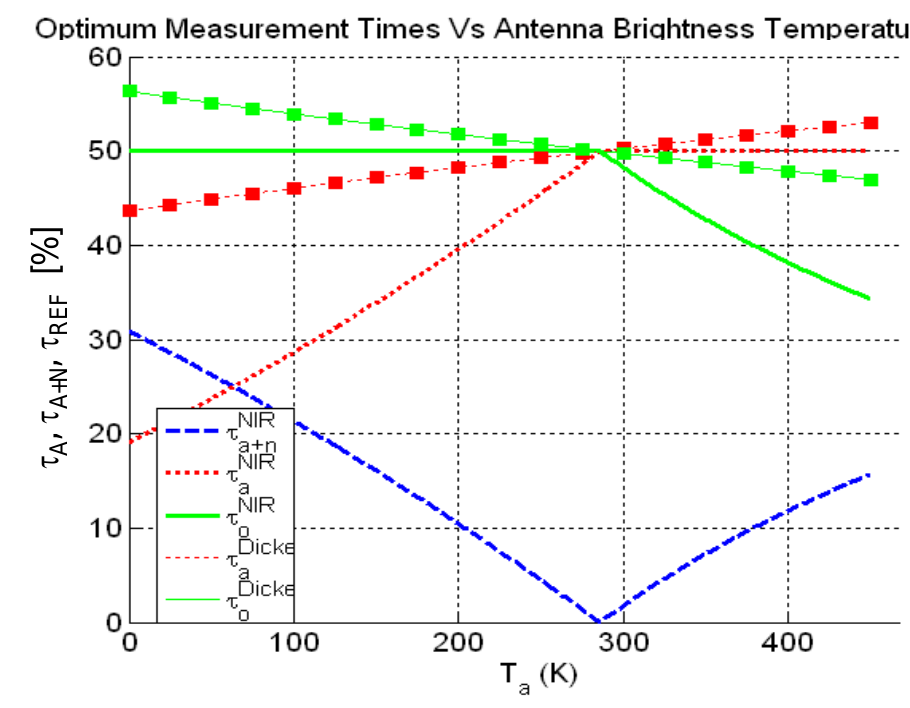
Figure 8. Optimum measurement times (τ time, for the NIR and the Dicke configurations as a function of the antenna temperature (T A